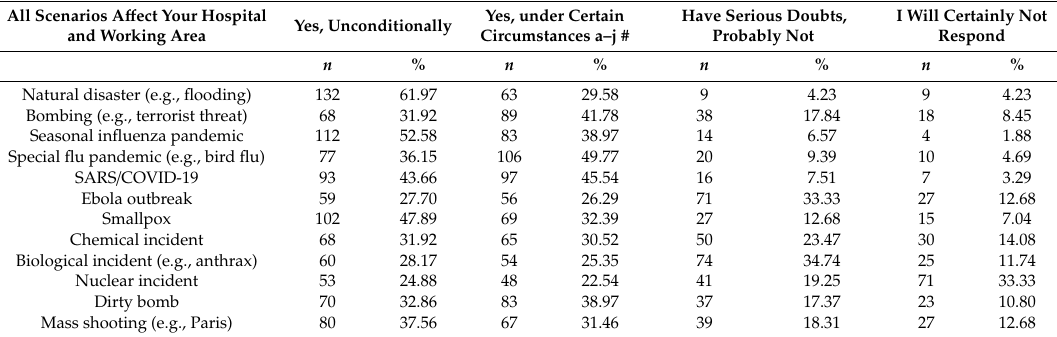
Table 2. Willingness to go to work during various conditions ( n =